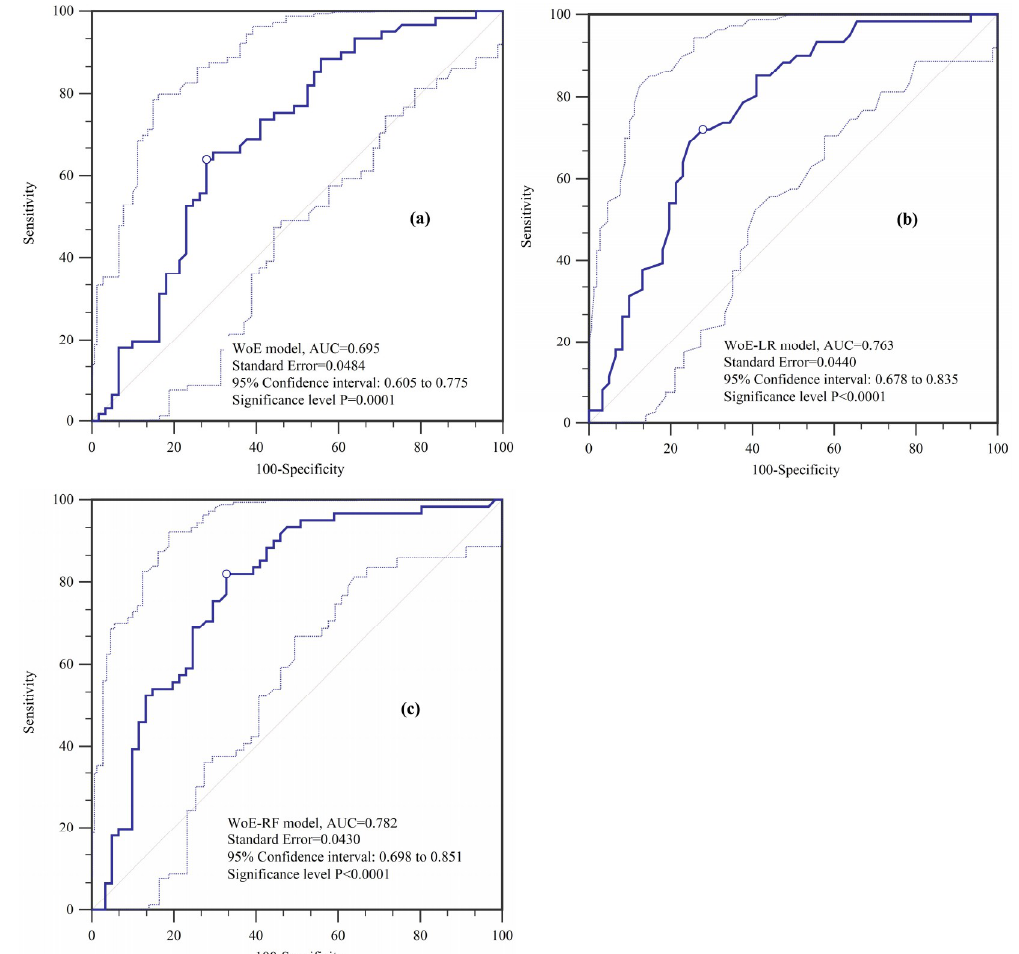
Figure 9. ROC curves using the validation dataset.